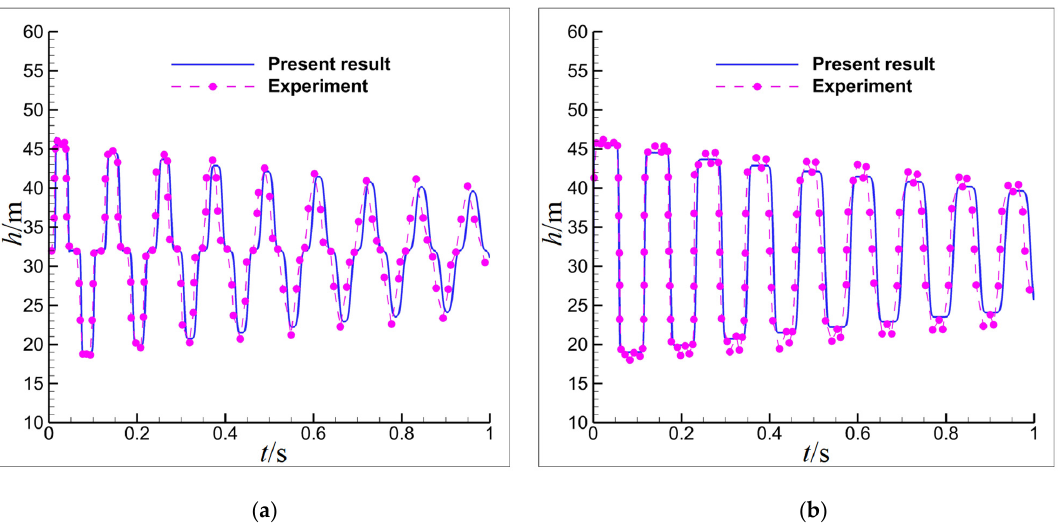
Figure 2. Comparison of water heads between the present simulation and experimental data when V 0 = 0.1 m/s: ( a ) at the midpoint, ( b ) at the valve (endpoint).